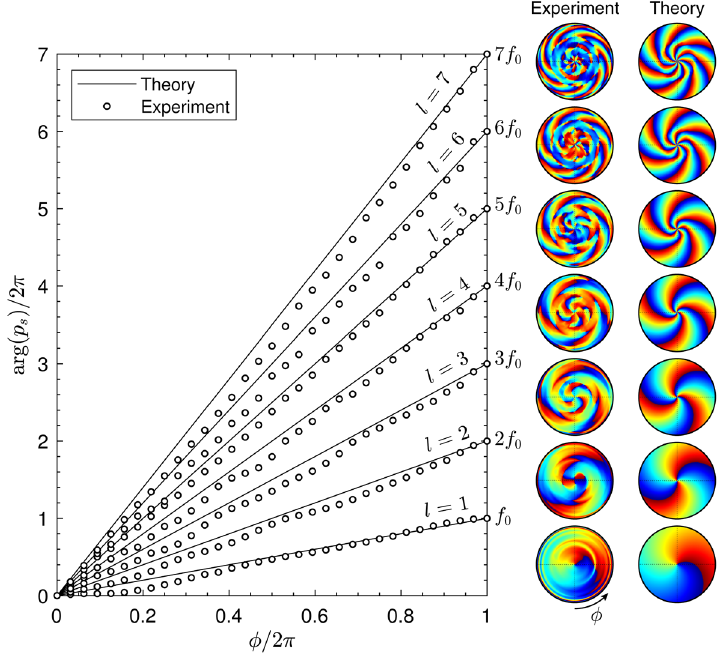
Figure 6. Phase of the scattered field in the far field as a function of the azimuthal angle. Each curve corresponds with a frequency and its associated topological charge of the scattered vortex, l , is indicated. The corresponding maps show the phase of the scattered field measured experimentally (interpolation was used here) and obtained using